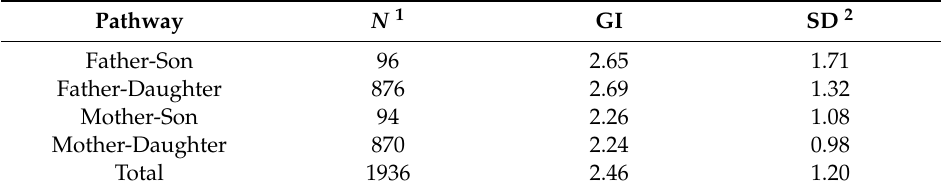
Table 2. Generation Interval (GI) calculated for each parental pathway.